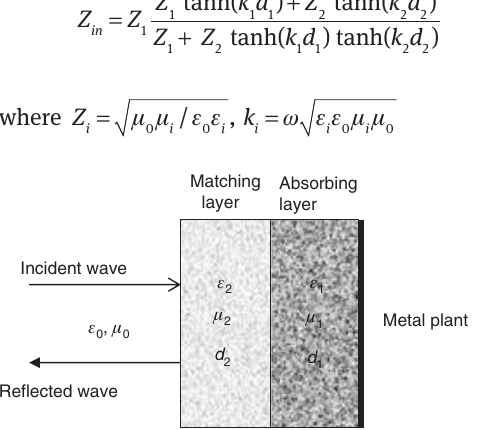
Figure 4: Schematic illustration of the double-layer cement com- posite consisting of a matching layer and an absorbing layer.